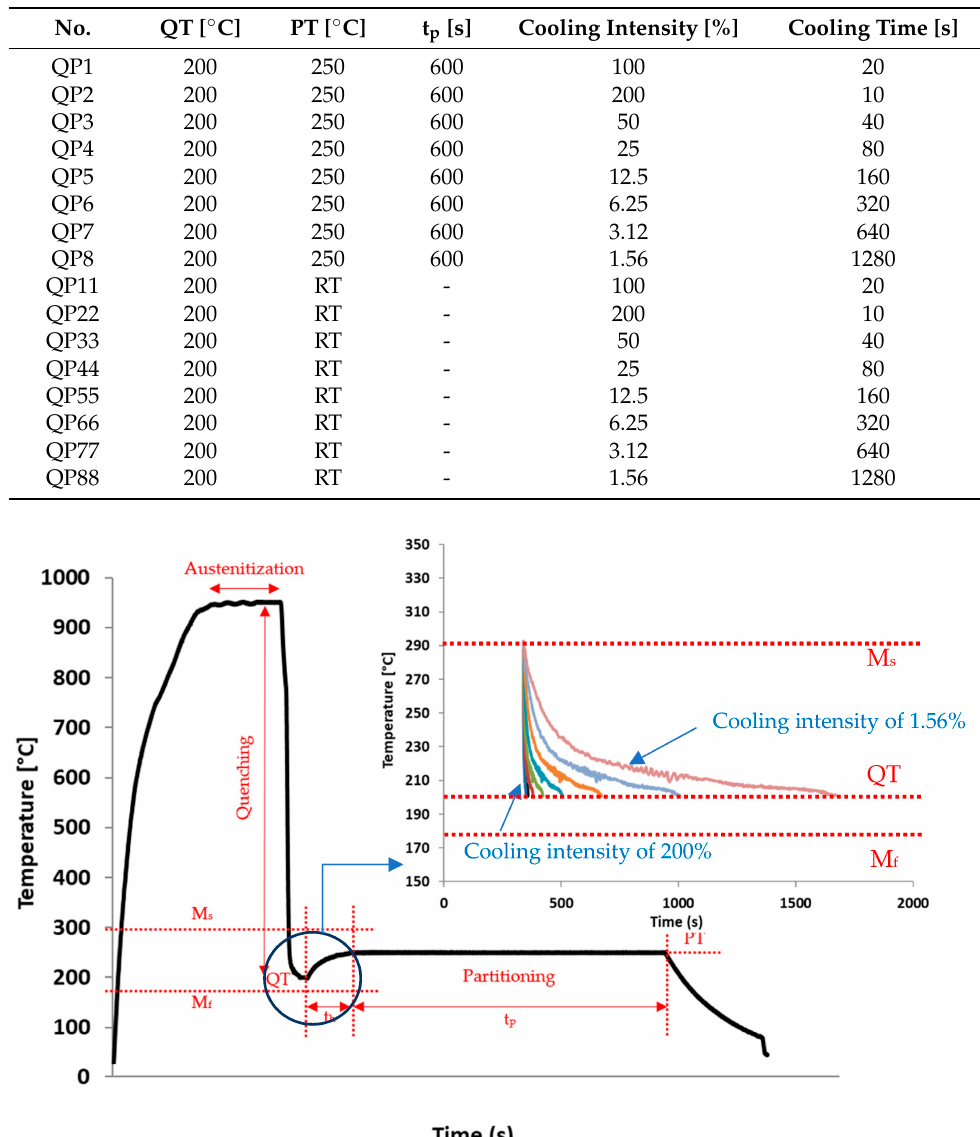
Table 2. Q-P process parameter.